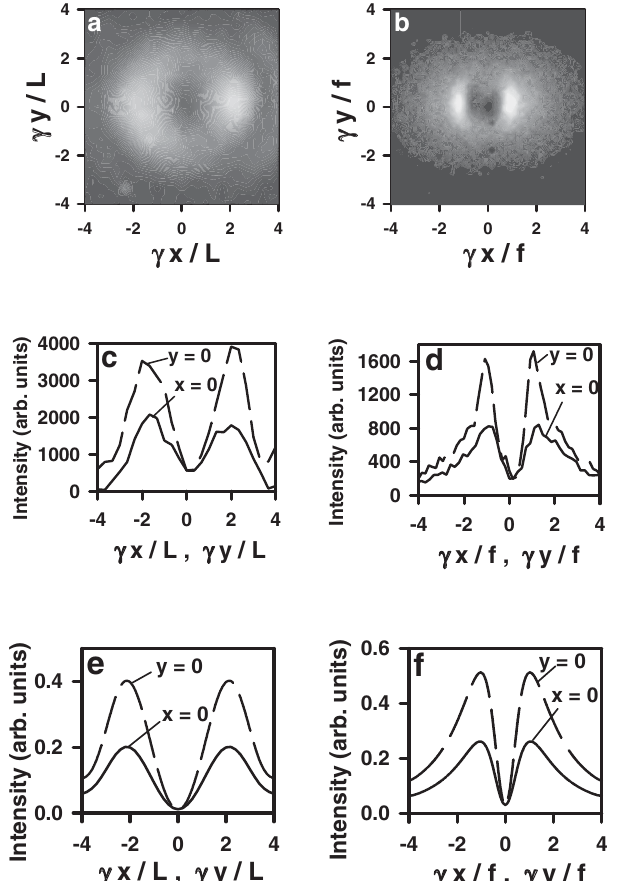
FIG. 17. OTR 3D spatial distributions measured with 450 nm filter without (a) and with (b) the lens ( f (cid:5) 0 : 2 m ); OTR 2D spatial distributions measured with 450 nm filter without (c) and with (d) the lens; OTR 2D spatial distributions calculated for 450 nm filter without (e) and with (f) the lens. The calculations were performed using Eq. (21) and the parameters were chosen to be the same as the experimental ones.